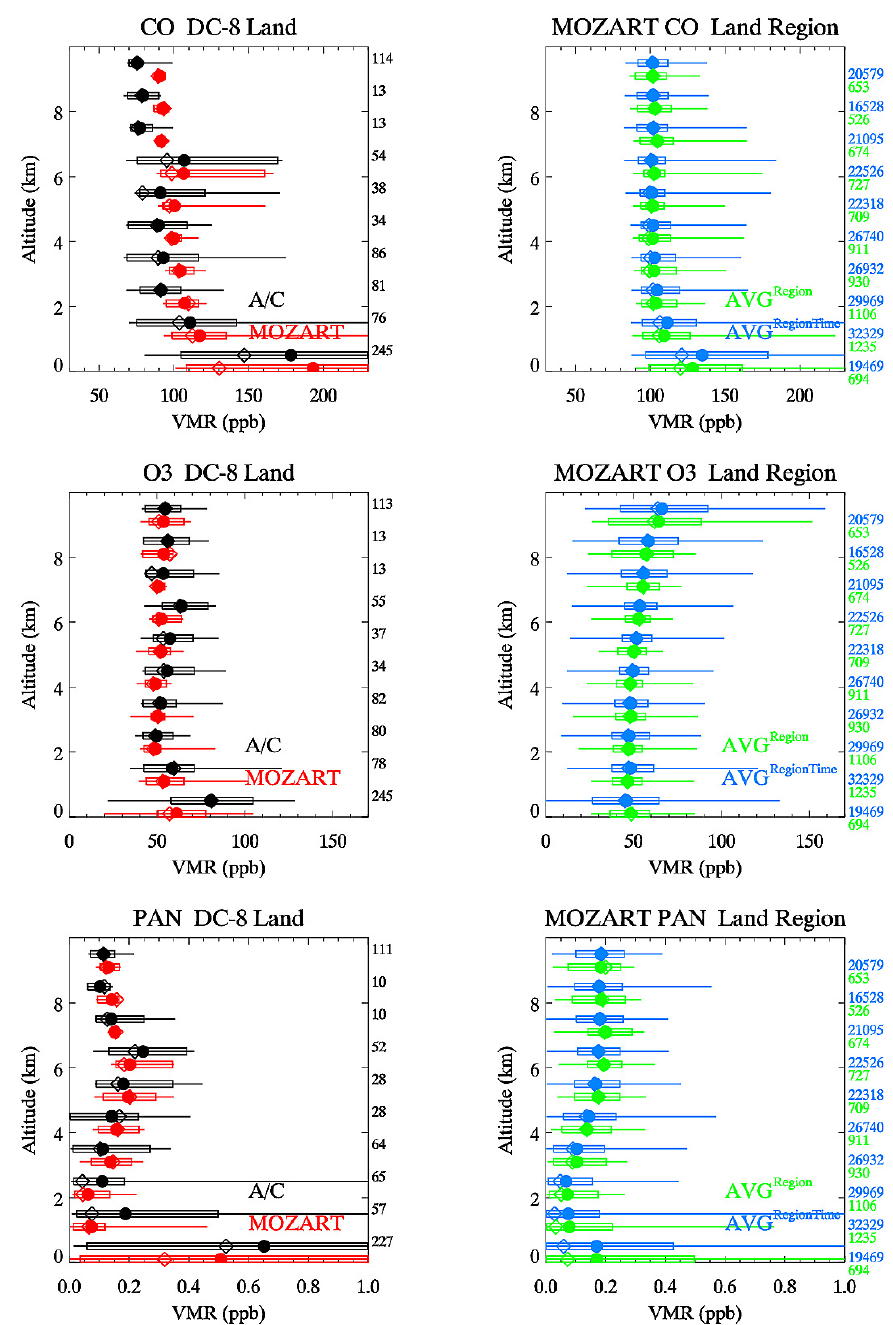
Fig. 5. As Fig. 2 but for DC-8 Land data sets and the data have been filtered for fire influence.